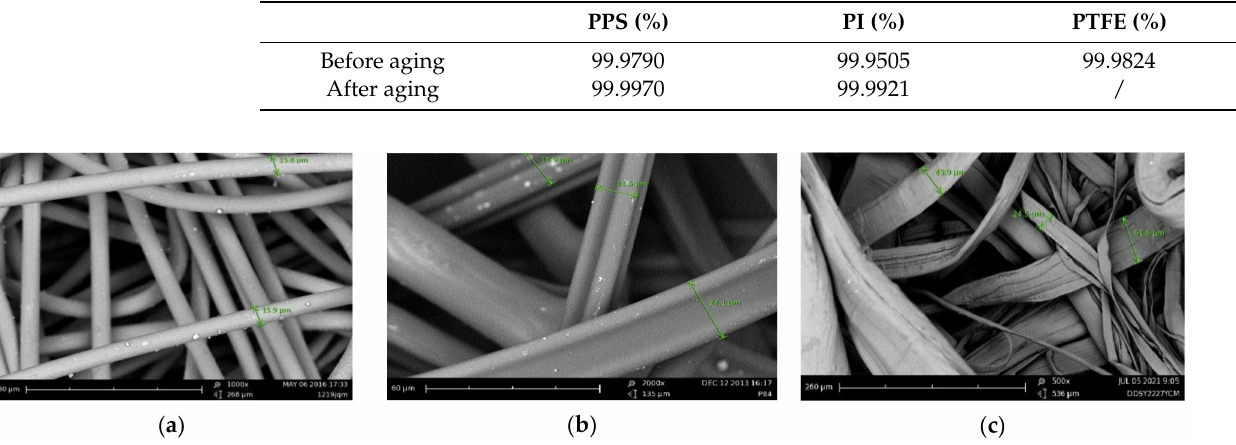
Figure 3. Surface electron microscopy of ( a ) PPS, ( b ) PI, and ( c ) PTFE.